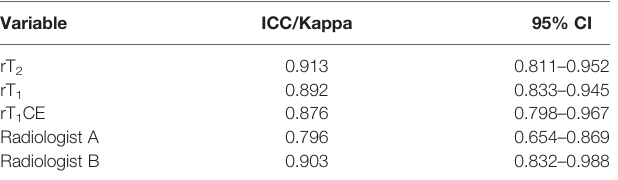
TABLE 6 | Reproducibility of signal intensity ratio measurements and radiologists ’ assessment. Variable ICC/Kappa 95% CI